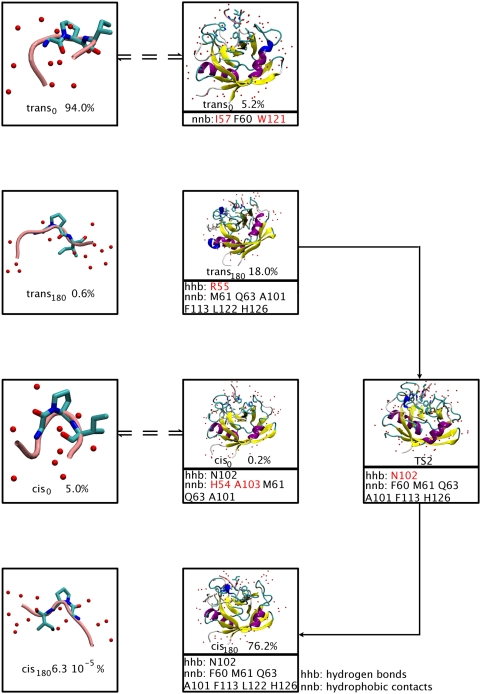
Proposed mechanism of action for CypA.CypA sequesters the most abundant conformation in water, trans0, that is rapidly interconverted into the most abundant conformer trans180. Then, CypA catalyzes the isomerization of the peptide along TS2, producing the mostly populated minimum, cis180. The peptide most probably detaches in the cis180 conformation. This readily interconverts to cis0 once the peptide is in aqueous solution. CypA residues that form important H-bonds (hhb) and hydrophobic interactions (nnb) with the G3P4 moiety are shown. Residues with almost exclusive relevance to each conformation are highlighted in red.